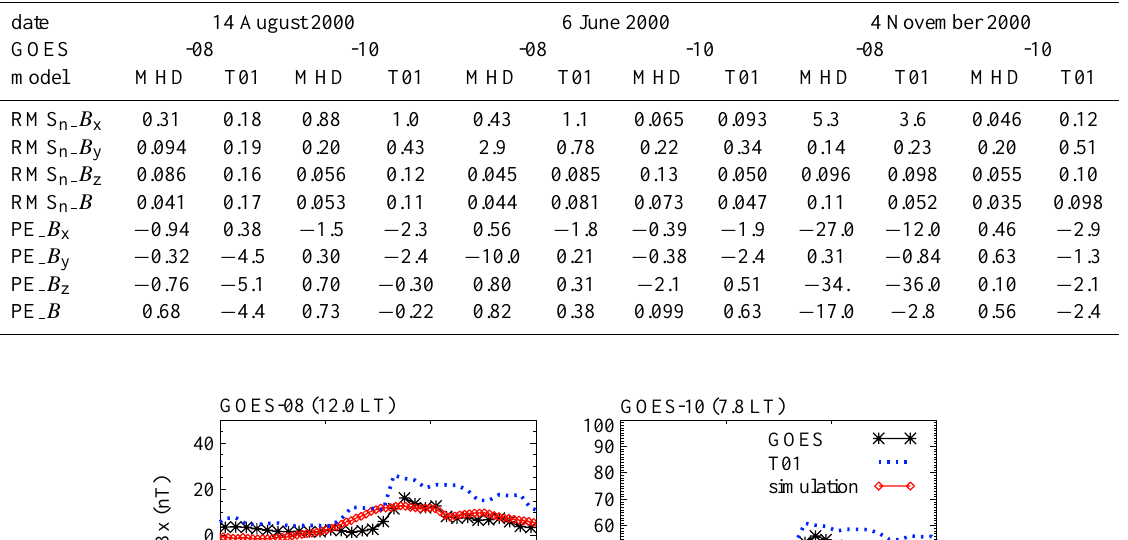
Table 2. Normalized root mean square (RMS n ) and prediction efficiency (PE, defined and discussed in Sect. 4.1) between GOES observation and MHD/T01 field model for the three studied events.